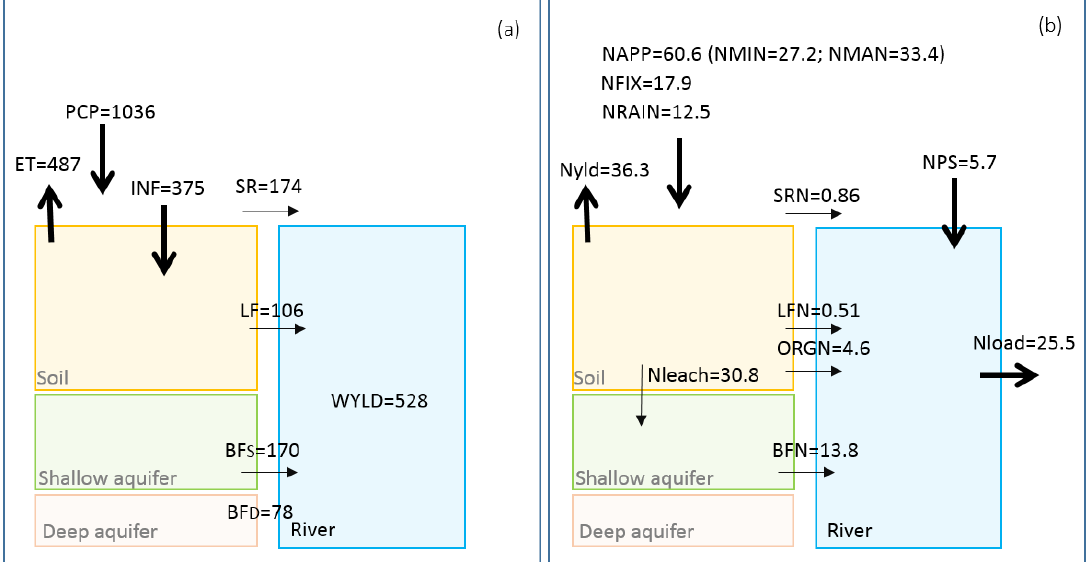
Figure 6. Long-term mean annual water, mm, ( a ) and nitrogen, kg/ha, ( b ) balances for the entire Po River Basin for the period 2000–2012. In ( a ): PCP precipitation, ET evapotranspiration, INF infiltration, SR surface runo ff , LF lateral flow, BFS groundwater from shallow aquifer, BFD groundwater from deep aquifer. In ( b ): NAPP nitrogen applied as fertilizer, NMIN nitrogen mineral fertilizer, NMAN